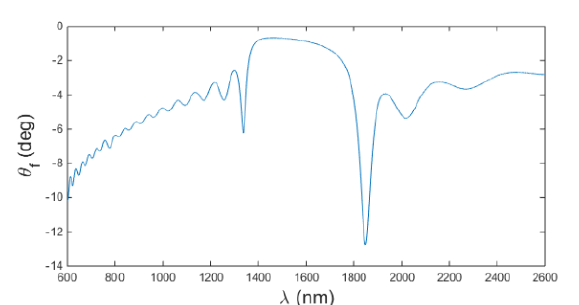
FIGURE 2. Transmittance (a) and the Faraday rotation (b) spectra of 1D photonics crystal made with magneto-optic layers without defect [4].